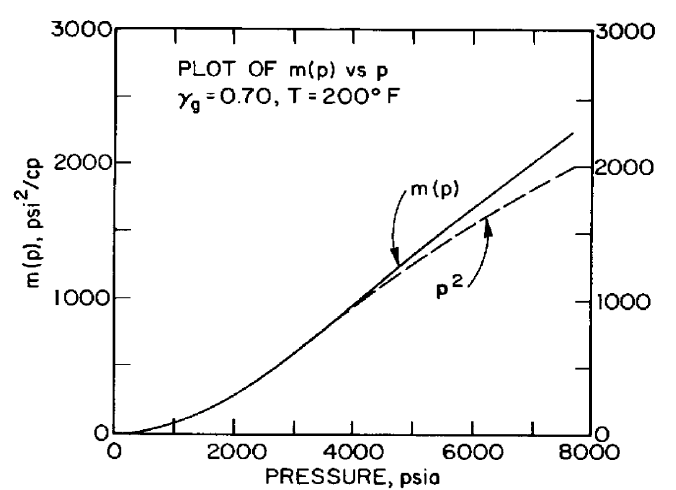
Figure 4. Plots of gas potential versus P 2 and m(P) [20]. model, and the system described in this manuscript is a tight gas reservoir underlain by a bottom-water aquifer providing the drive, as shown in Figure 5.